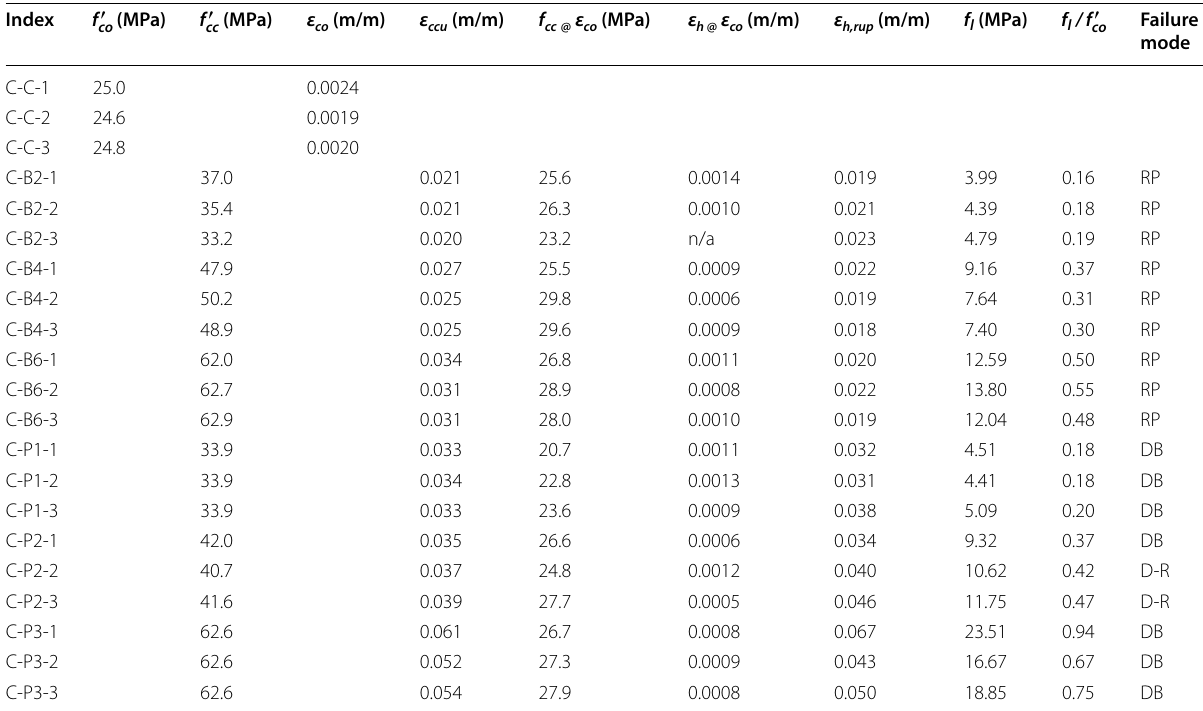
Table 6 Summary of FRP confinement test